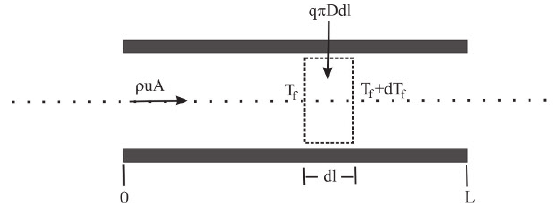
Figure 1. Control volume for internal flow in a tube